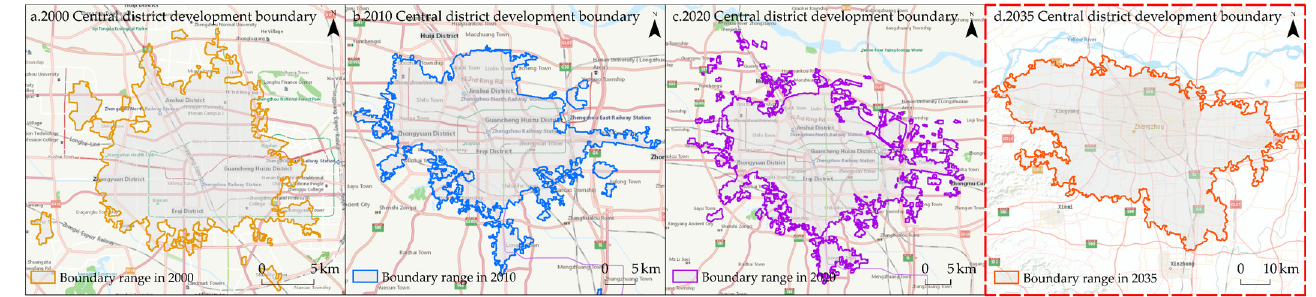
Figure 7. Comparative analysis of the development boundary of the central district from 2000 to 2035.